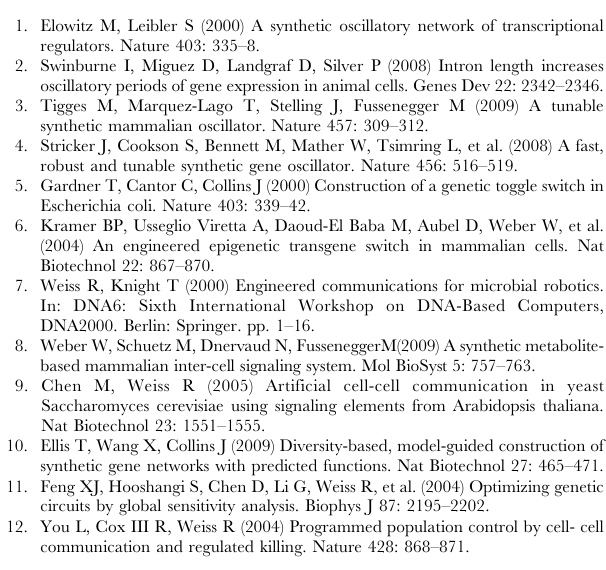
Table S9 Summary of the advantages and disadvantag- es of Systems